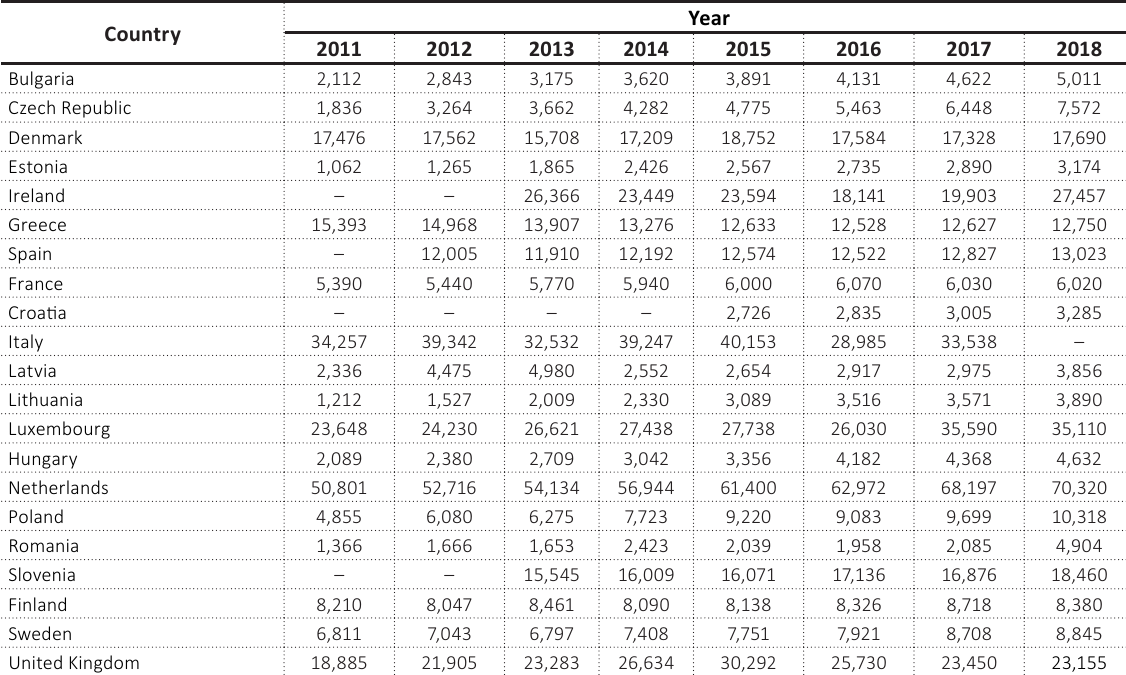
Table 1. Agricultural lands prices by region (last update: 21-01-2020),